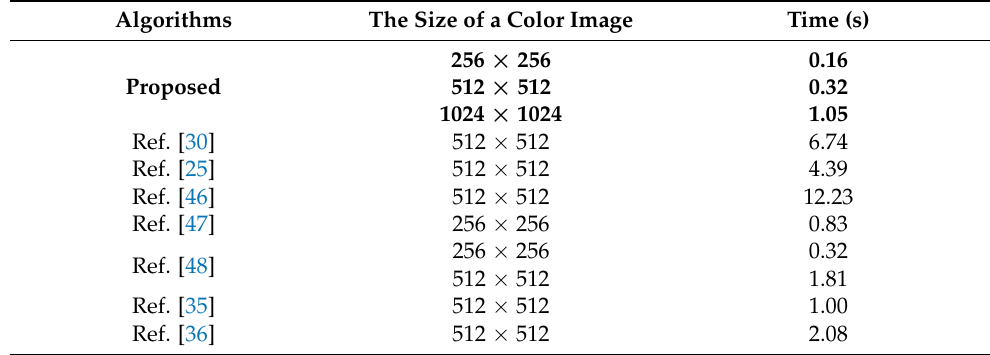
Table 17. Algorithms’ encryption time (The bold part is the values of the proposed